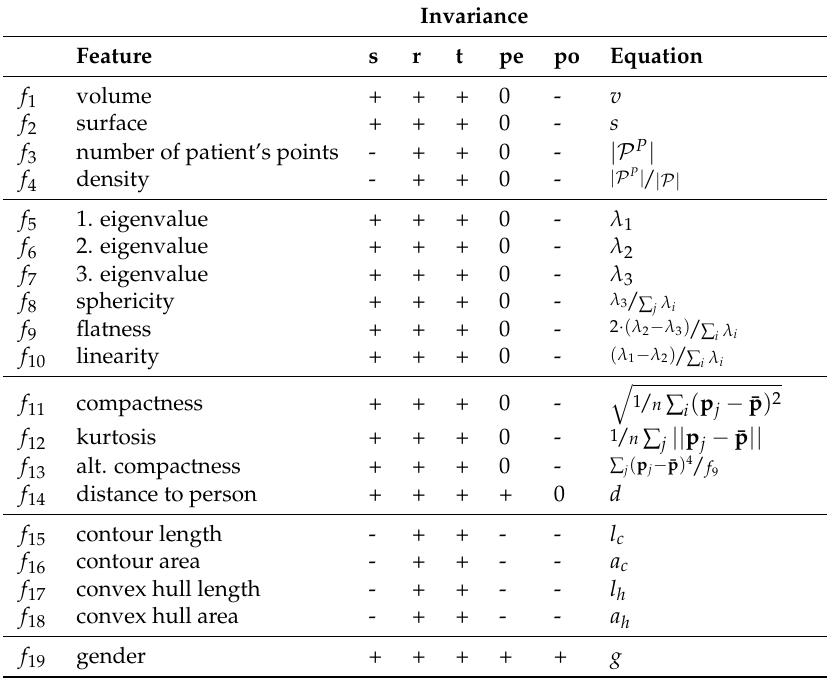
Table 4. List of features for body weight estimation ∀ p j ∈ P P . The table further lists the invariance of each feature by scale (s), rotation (r), translation (t), perspective (pe) and posture of the person (po) with + (invariant), 0 (invariant with limitations) and - (not invariant). The equations in the table are taken from the previous work